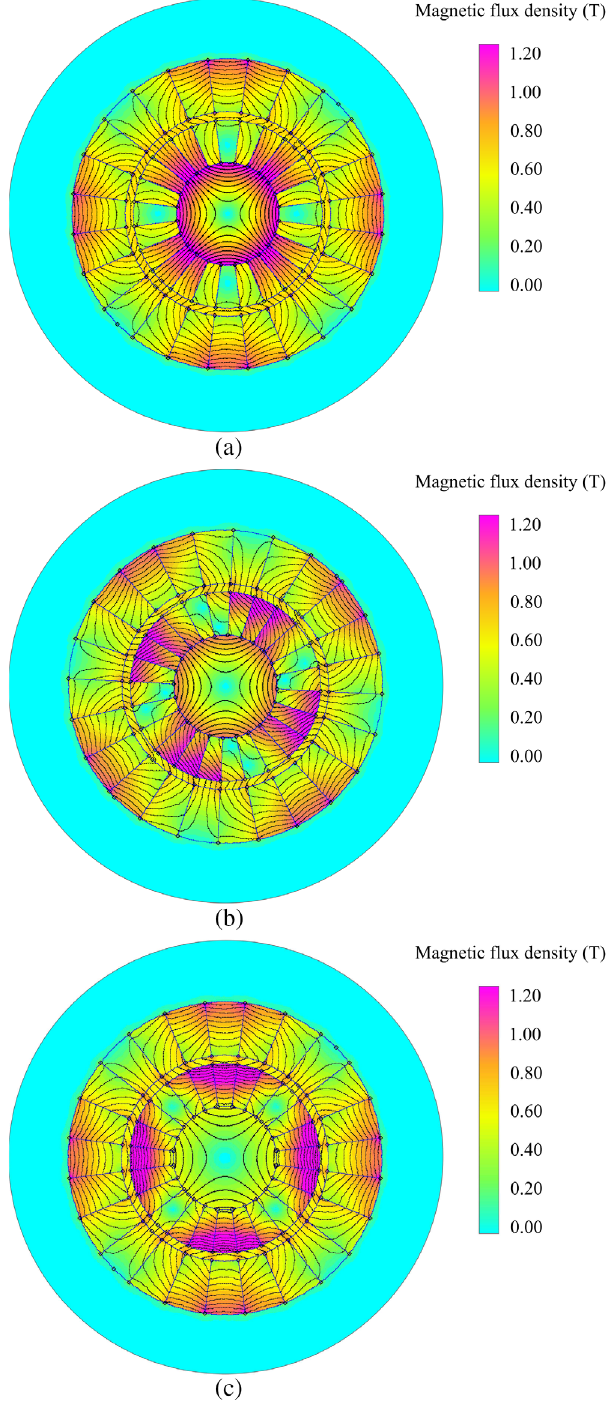
FIG. 14. Magnetic field in the concentric design when